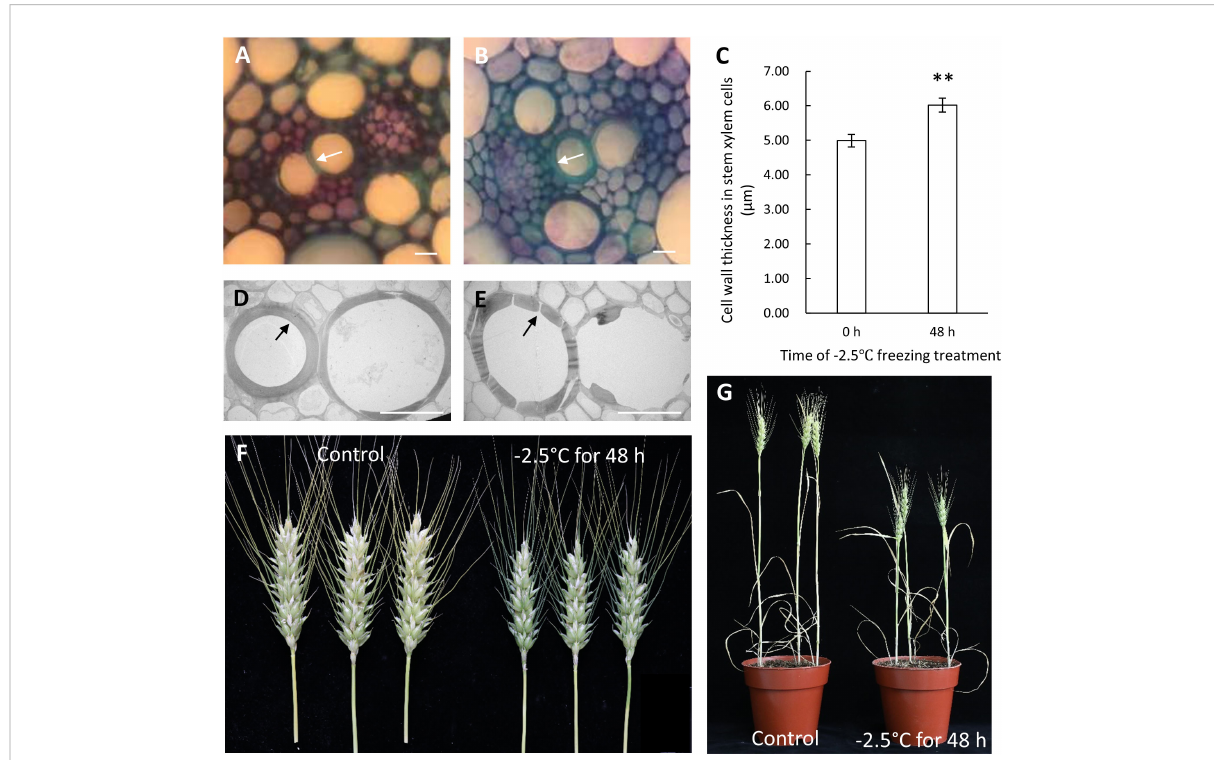
FIGURE 1 The phenotypic reactions of Zhongmai8444 treated with freezing stress at meiotic stage. (A) Morphology of cell walls in xylem cells when plants were grown in normal growth condition. (B) Cell wall thickening was observed in plants treated with -2.5°C for 48 h. (C) Bar graph represents the cell wall thickness of xylem cells in control and freezing-treated plants. Data are mean ± SE calculated from three biological replicates. ** indicates a signi fi cant difference (p-value < 0.01) using a Student ’ s t-test. (D) TEM imaging showed that the cell walls of xylem cells were not disturbed in plants grown in normal growth condition. (E) Cell walls of xylem cells were severely damaged when plants were treated with -2.5°C for 48 h and recovered at room temperature. (F) Spike length and seed setting were dramatically reduced in plants treated with -2.5°C for 48 h (on the right) compared to plants grown in normal growth condition (on the left). (G) Freezing stress at meiotic stage leads to reduced plant height. Scale bars represent 20 m m.